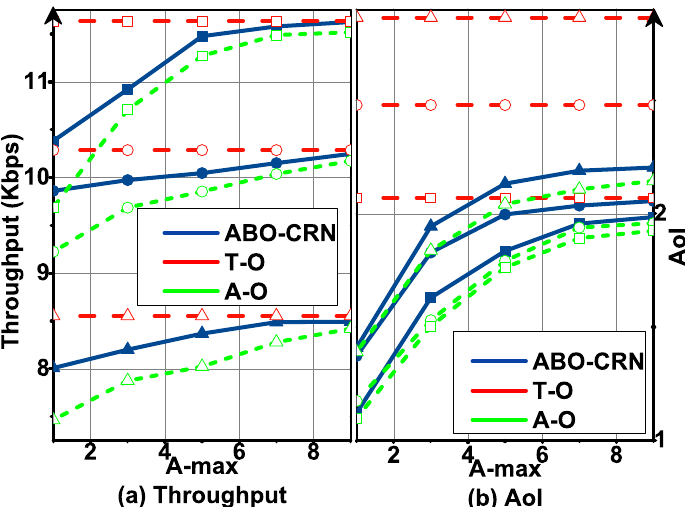
Figure 7. Throughput T and AoI versus A max under P a = 0.3 (circle), 0.6 (square), 0.9 (triangle) compared with that of T-O and A-O baseline schemes, and T min = 700 bps: ( a ) describes the throughput performance. ( b ) describes the AoI performance.